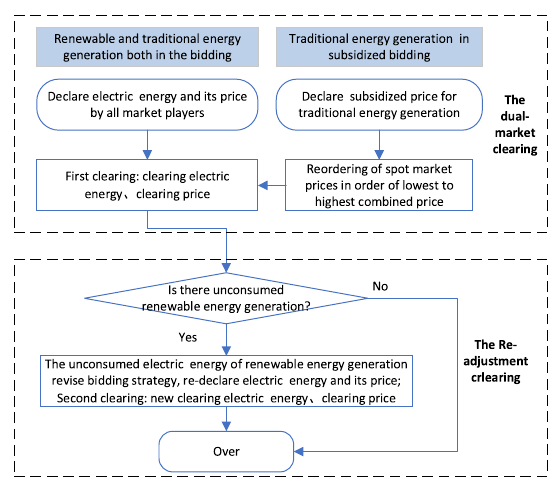
Fig. 3 Market clearing in the re-adjustment market mechanism Fig. 4 Flow chart of the two-stage market clearing